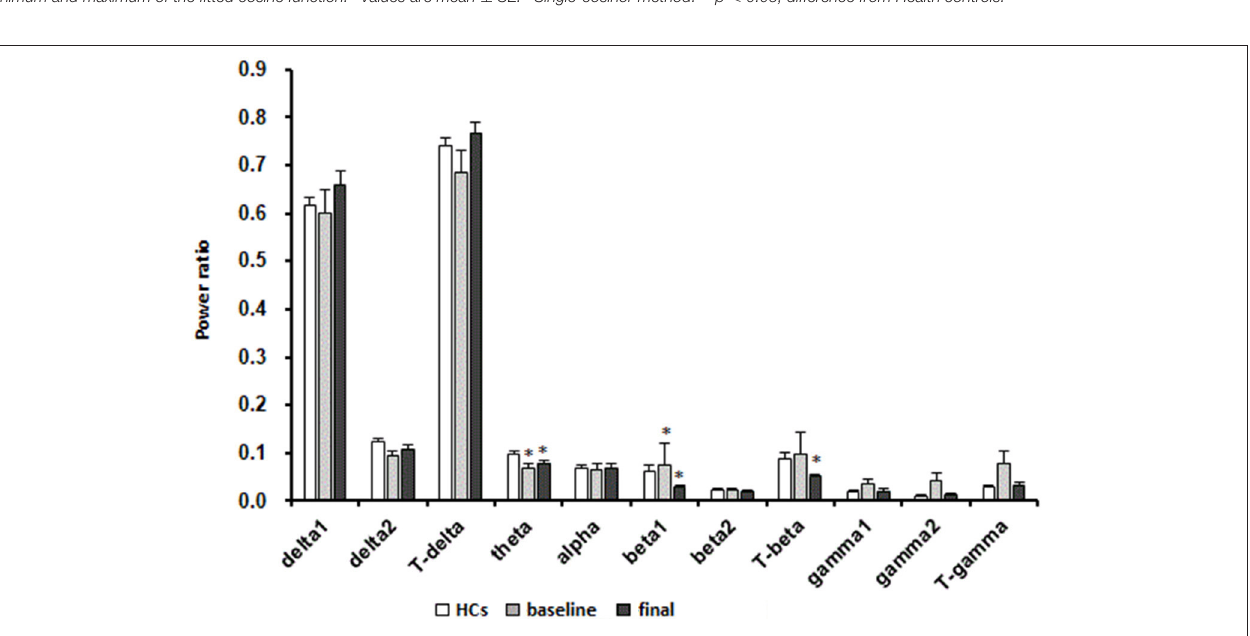
frequency band in the right hemisphere in patients with MDD at baseline compared with that in HCs ( p < 0.05). After 8 weeks of escitalopram treatment, the theta frequency band in the right hemisphere in patients with MDD was still significantly lower than that in HCs ( p < 0.05). Significant changes in the EEG power ratios in the left and right hemispheres were seen after 8 weeks of escitalopram treatment. The delta1 frequency band significantly increased, and the delta2 frequency band significantly decreased in the right hemisphere compared with in the left hemisphere in patients with MDD ( p < 0.05). The theta and alpha frequency bands significantly decreased in the right hemisphere compared with in the left hemisphere in patients with MDD ( p < 0.05; Supplementary Table 1